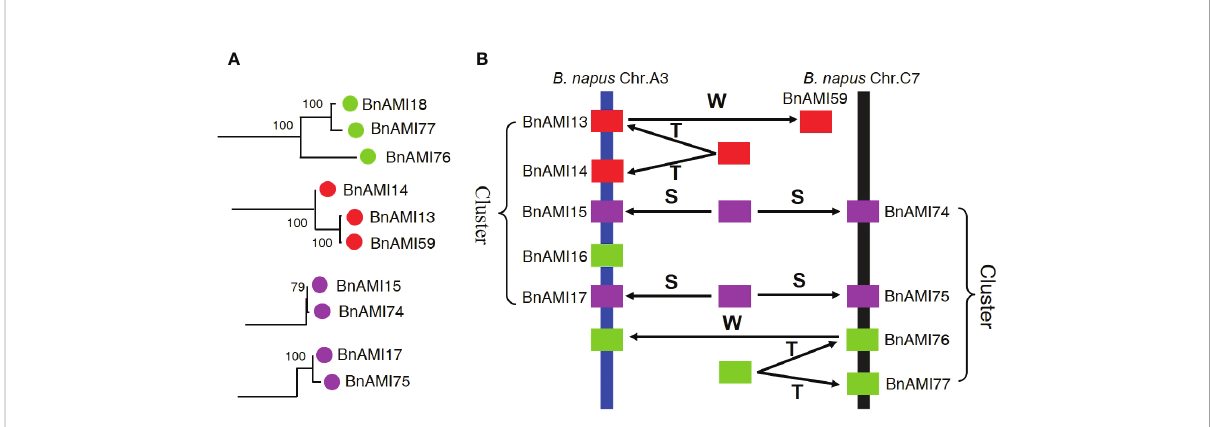
FIGURE 4 Phylogenetic relationships and hypothetical evolutionary progress of the cluster of BnTAR genes in B. napus chromosomes A3 and C7. (A) Phylogenetic relationships of selected BnTAR genes in the cluster. (B) Hypothetical mechanism of BnTAR gene cluster formation. The letters T, S, and W indicate putative tandem duplication, segmental duplication, and whole-genome duplication,